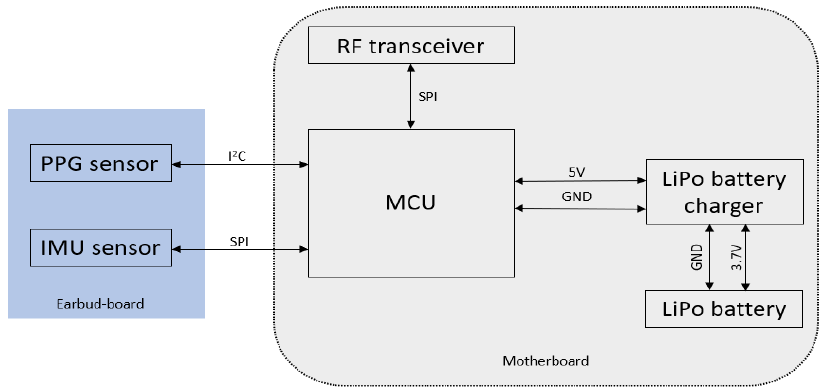
Figure 1. Block diagram of the proposed hardware system.